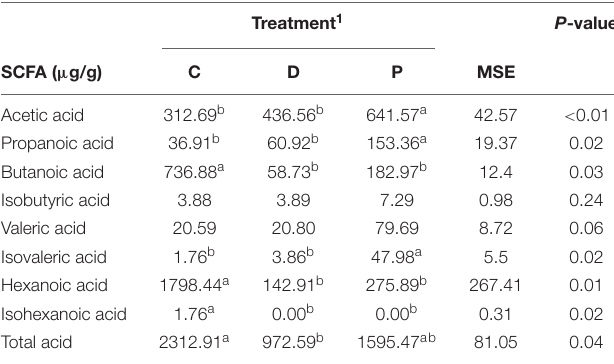
TABLE 2 | Short chain fatty acid (SCFA) concentration and molar proportion in the jejunum contents of neonatal calves. Treatment